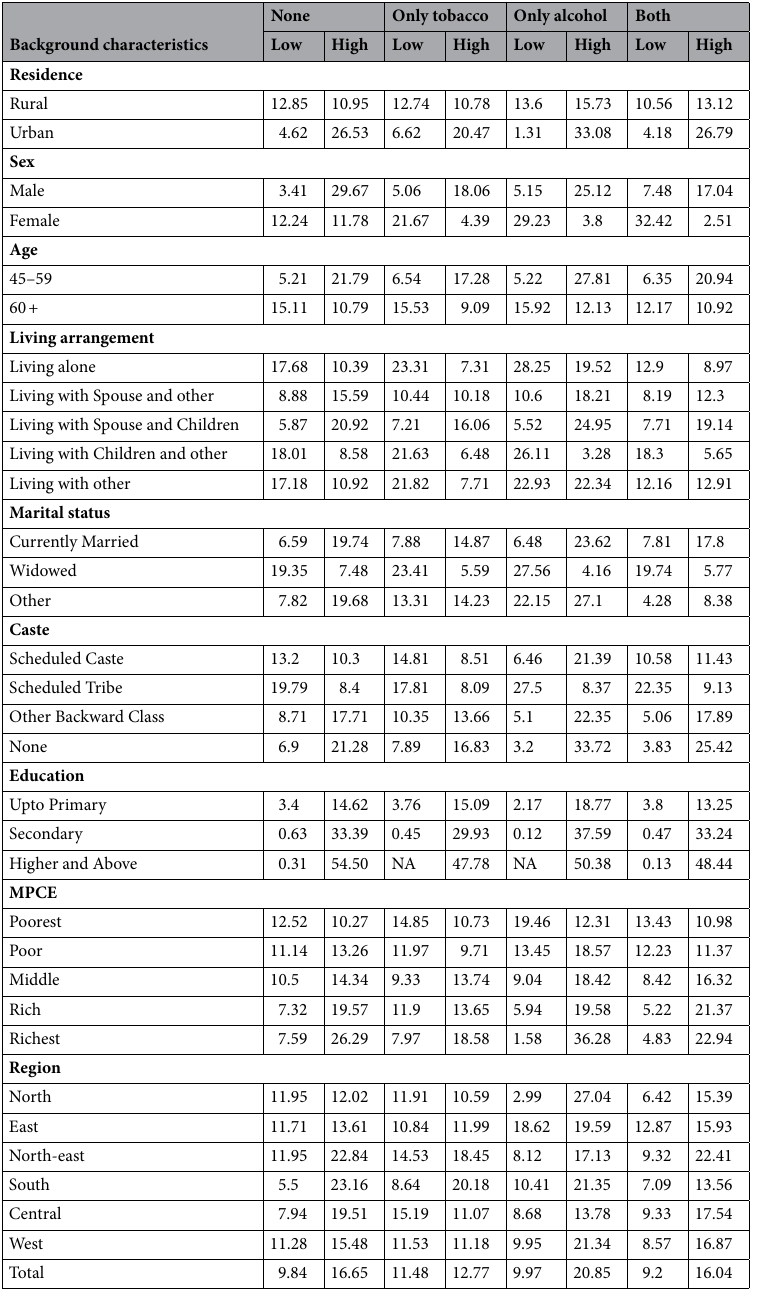
Table 2. Prevalence of low and high cognition among older adults aged 45 and above by alcohol and tobacco consumption behaviour and background characteristics of the individuals, LASI, Wave1,